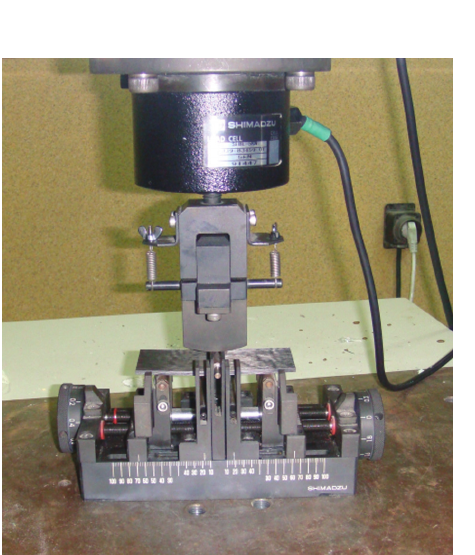
Figure 11 End-notched flexure (ENF) specimen for mode II testing mounted in the fixture.